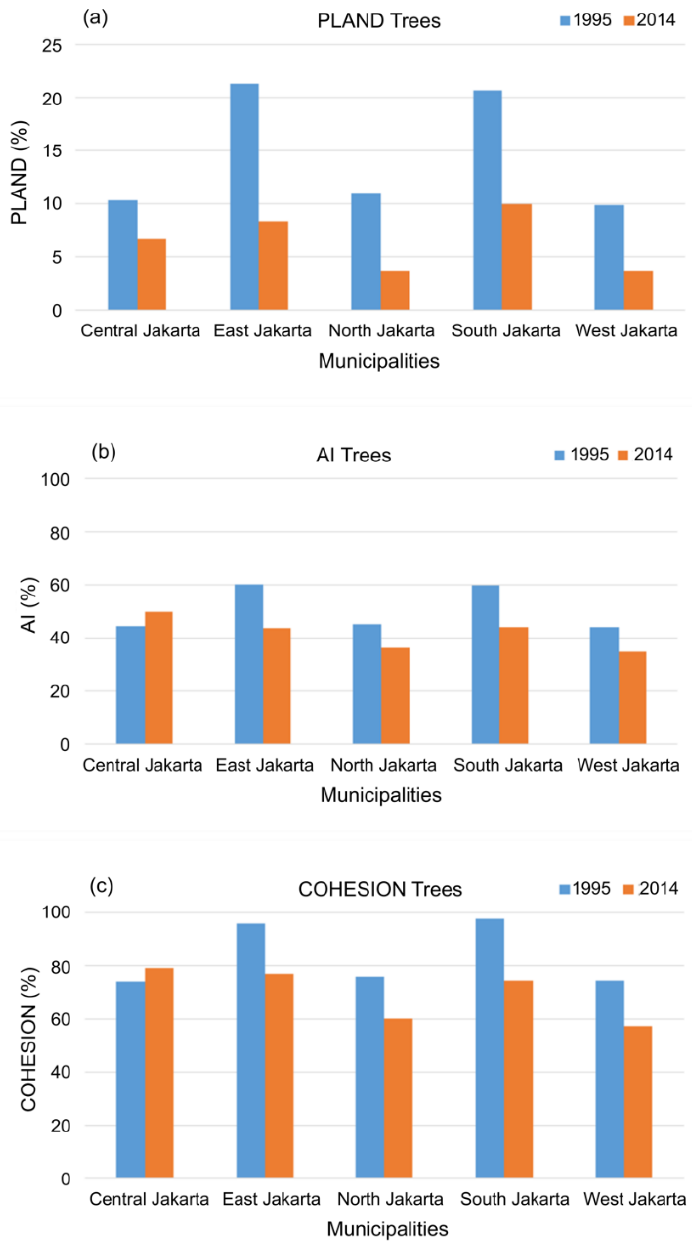
Figure 6. Landscape metrics of trees. ( a ) Land proportion; ( b ) aggregation index; ( c ) cohesion.